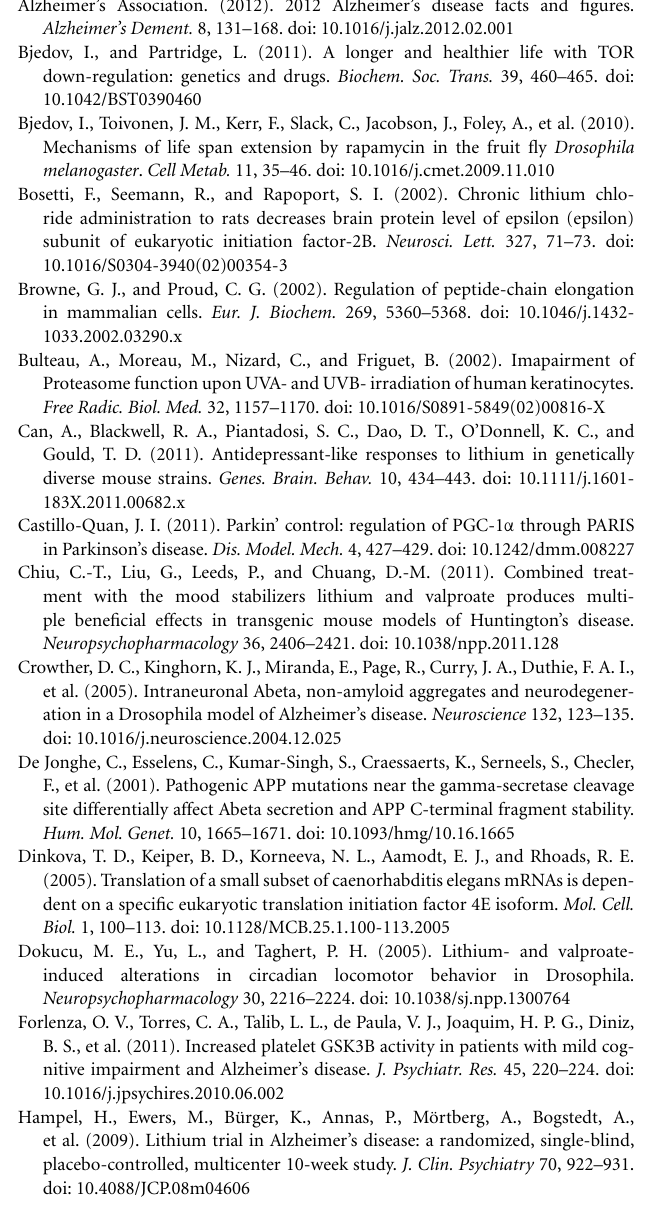
Supplemental Figure 1 | (A) Rapamycin did not rescue the climbing phenotype of UAS-ArcA β 42/ + ;elavGS/ + flies on + RU486 + 200 μ M rapamycin, P = 0 . 83 (B) Lithium suppressed the locomotor dysfunction phenotype, P < 0.05. Climbing ability of UAS-ArcA β 42/UAS-gfp ; elavGS/ + + RU486 and UAS-ArcA β 42/ + ;elavGS/ + flies on + RU486 + LiCl 10mM SY medium or + Rapamycin 200 μ M was assessed at the indicated time-points (see Materials and Methods). Data are presented as the percentage climbing performance of flies ± s.e.m. [Two-Way ANOVA, number of independent tests ( n ) =